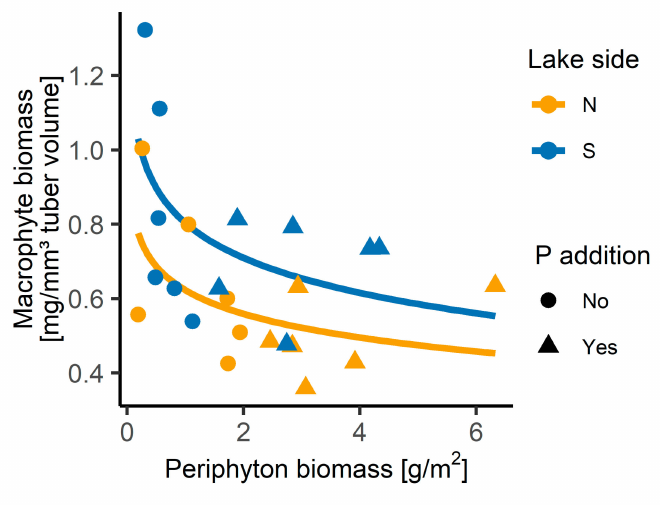
Figure 5. Final macrophyte biomass depending on periphyton biomass grown for 3 weeks on sediments from north-eastern (N) and south-western (S) shores of Lake Müggelsee with and without phosphorus (P) addition. Lines indicate the logarithmic relation (y = log(x)) between periphyton biomass (x) and macrophyte